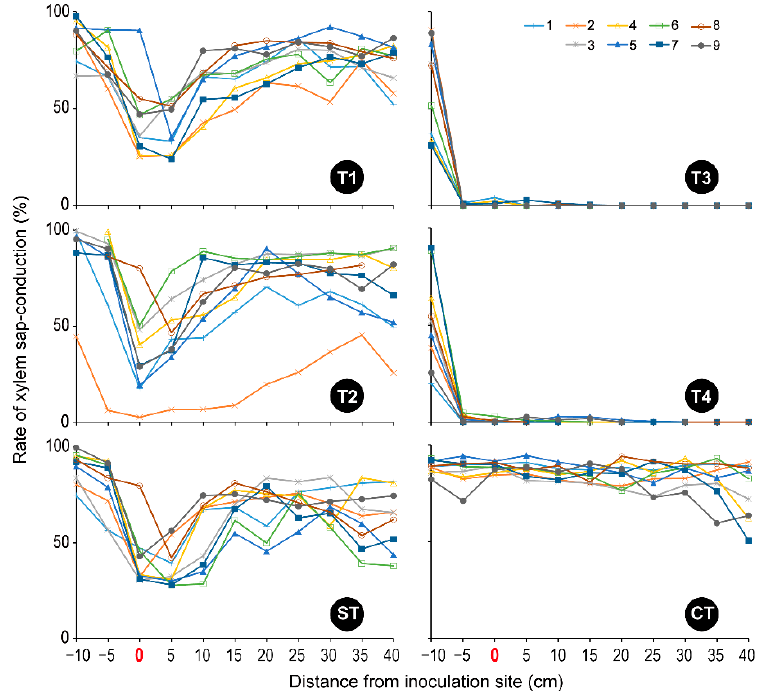
Figure 4. The rate of xylem sap-conduction in each fig sapling tested. T1: F. kuroshium ; T2: N. metavorans ; T3: C. ficicola ; T4: F. kuroshium + C. ficicola ; ST: sterilized toothpicks; CT: none. The treatment information is shown in Table 1.